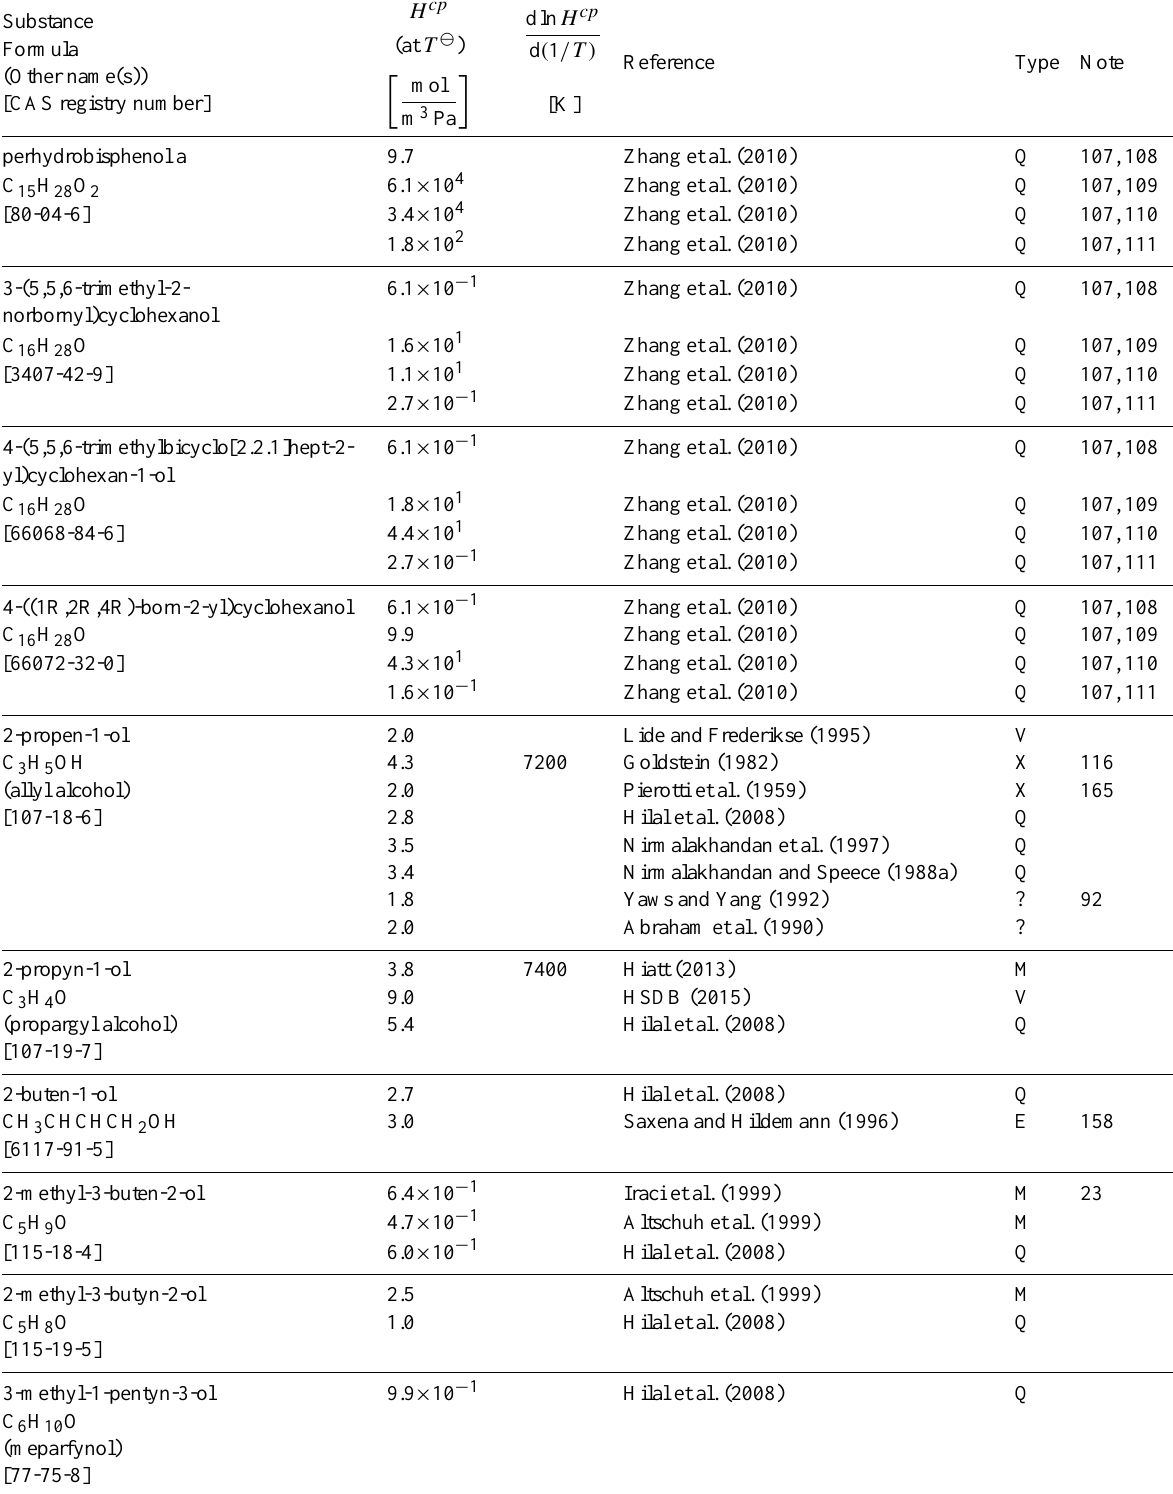
Table 6: Henry’s law constants for water as solvent